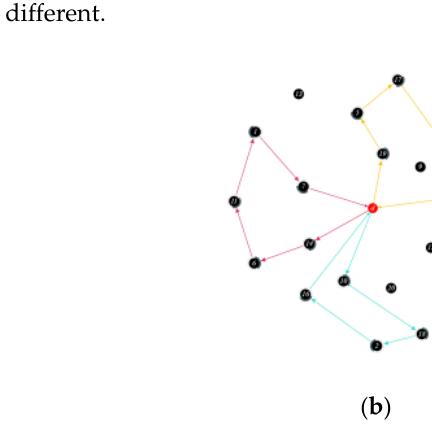
Figure 7. Time window durations and % of postponed deliveries.